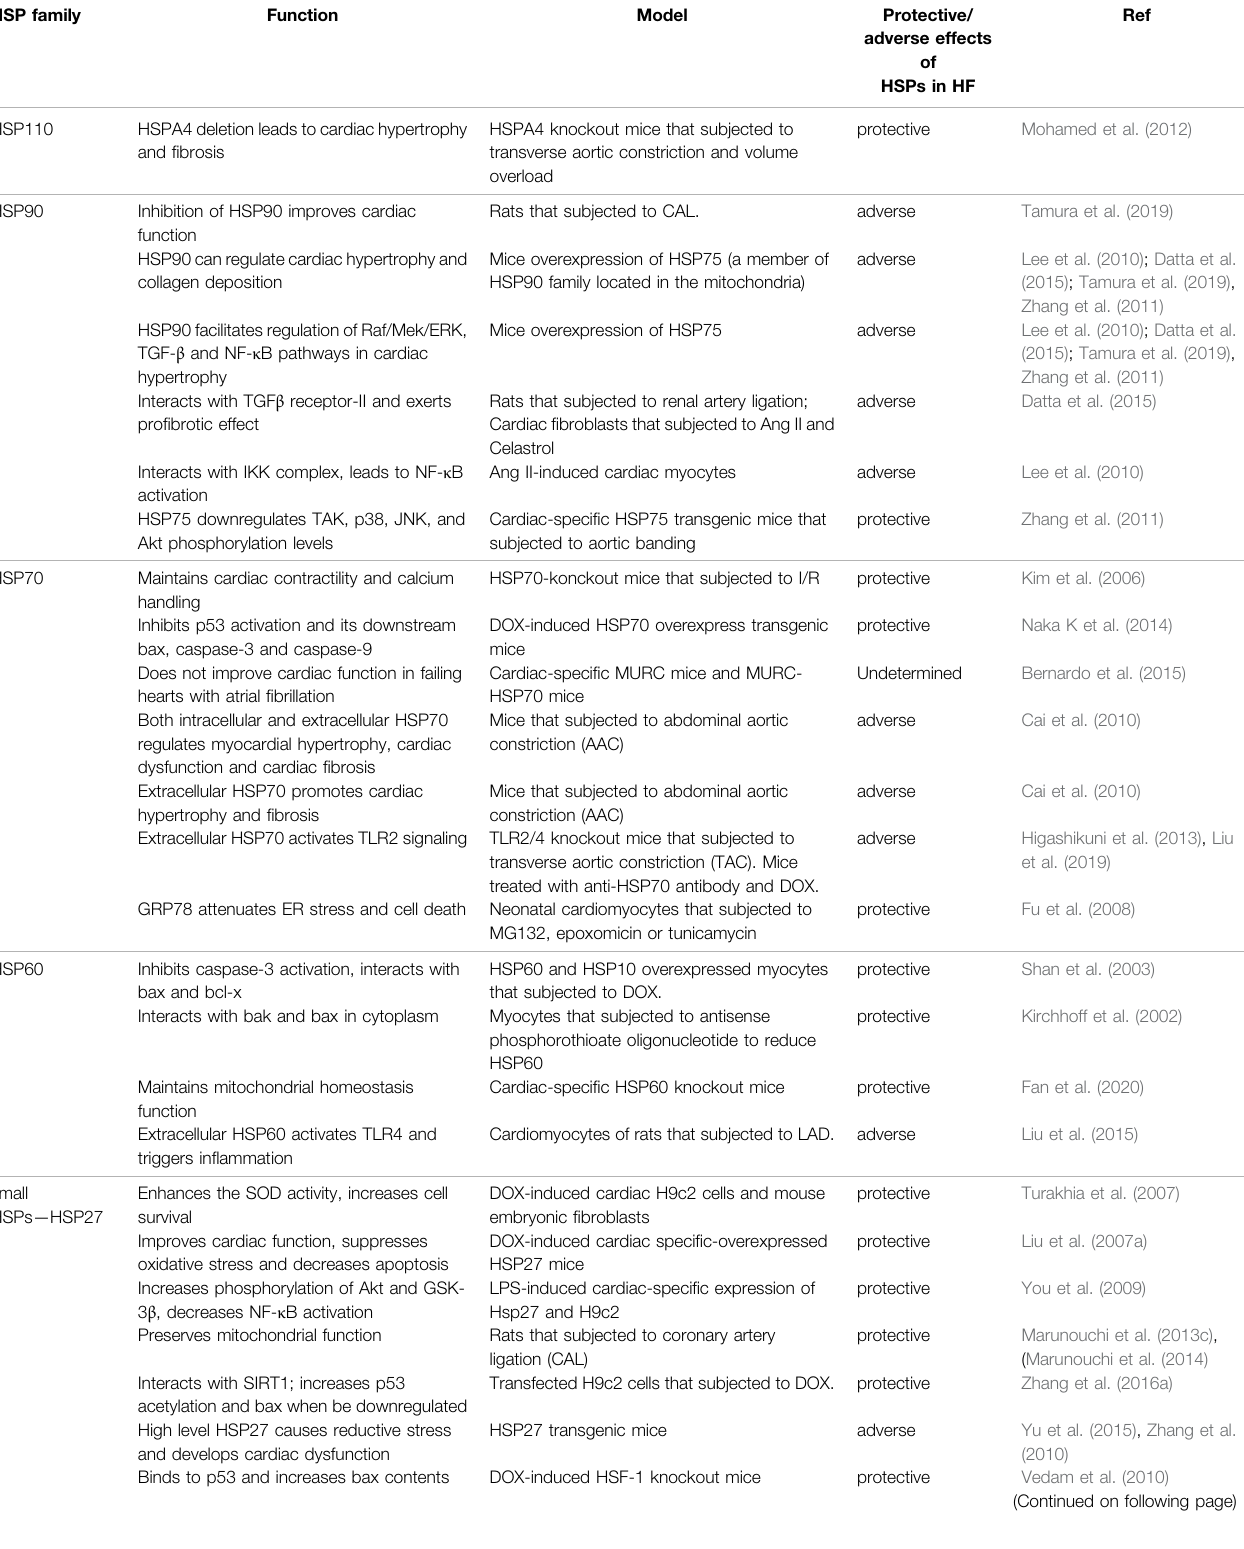
TABLE 1 | The functions of heat shock proteins in heart